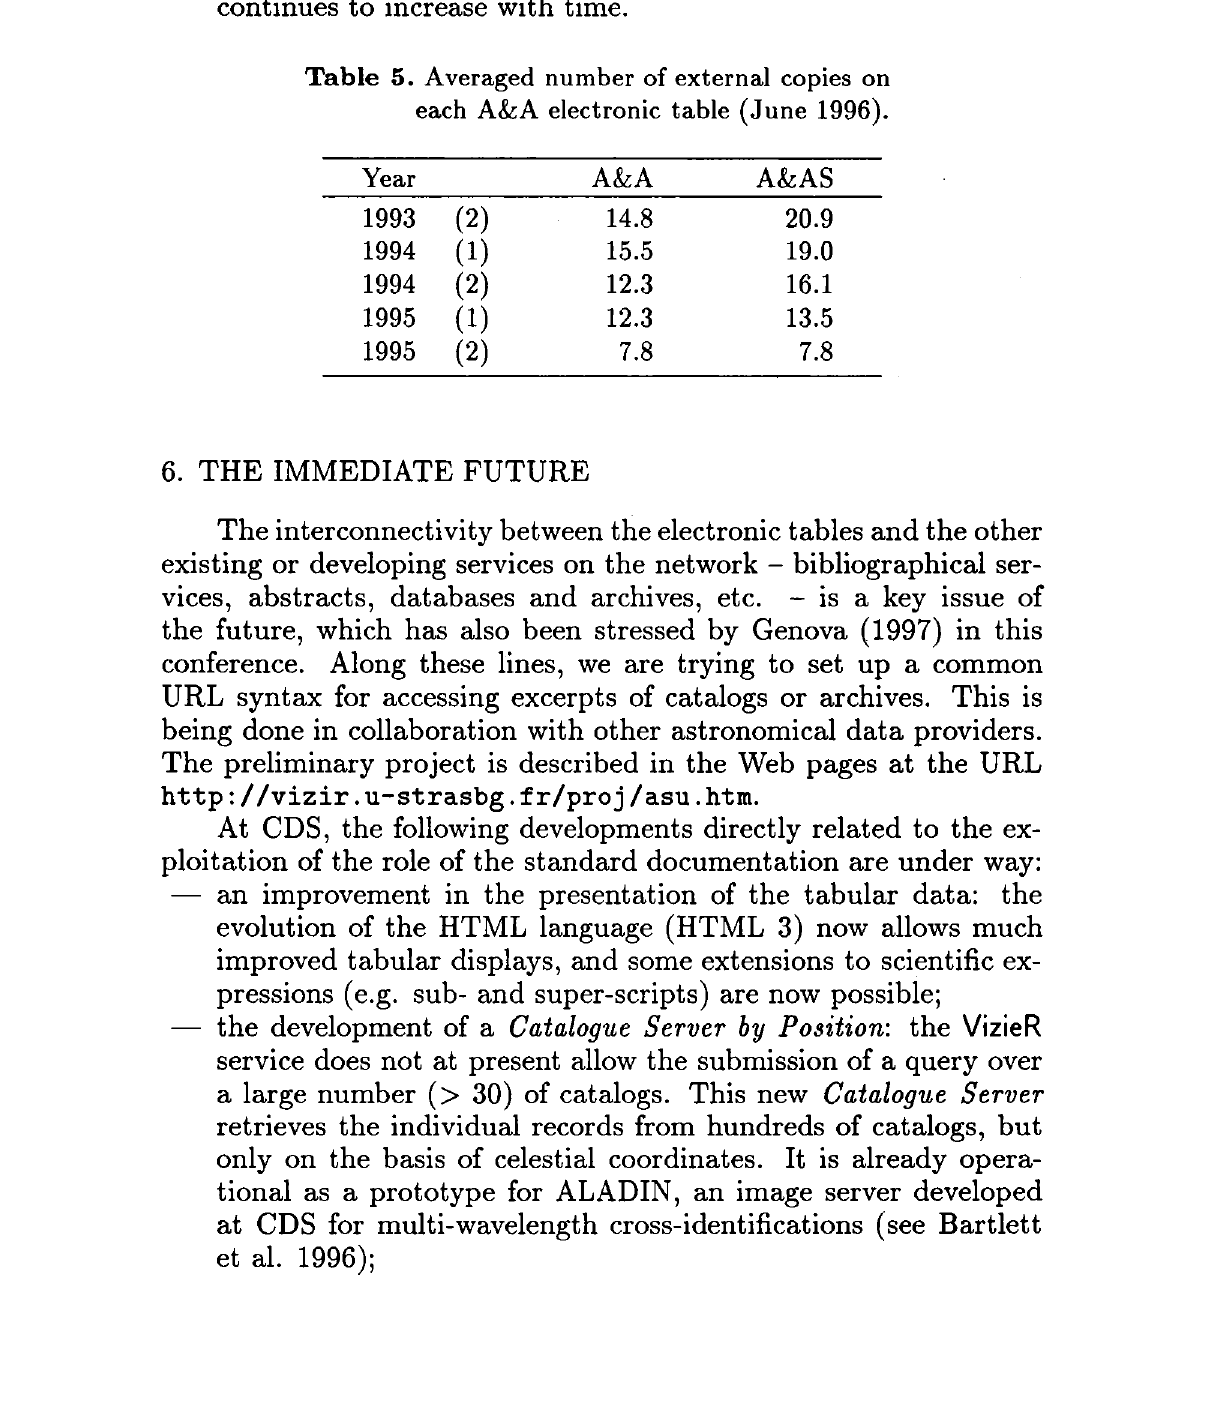
Table 5. Averaged number of external copies on each A&A electronic table (June